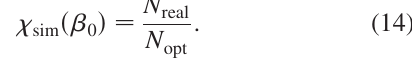
¼ 12 m ; vertical particle 0 ¼ 0 : 388 mm . The absorbing coefficient is 3.3%. ELEGANT x